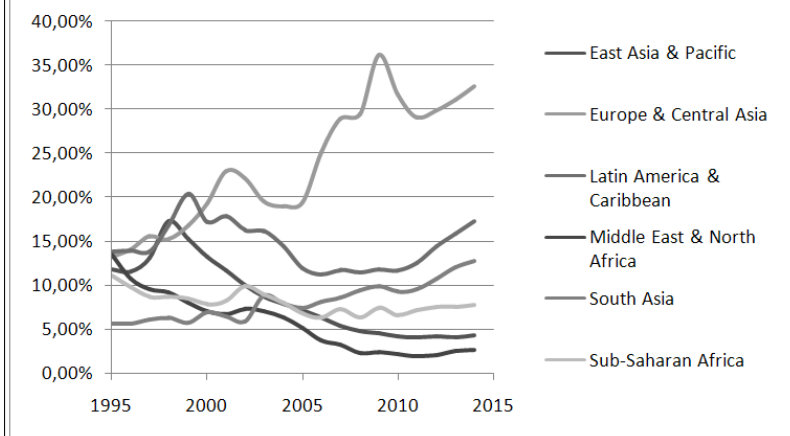
Fig. 8. Trends in VR external debt to GDP region-wise